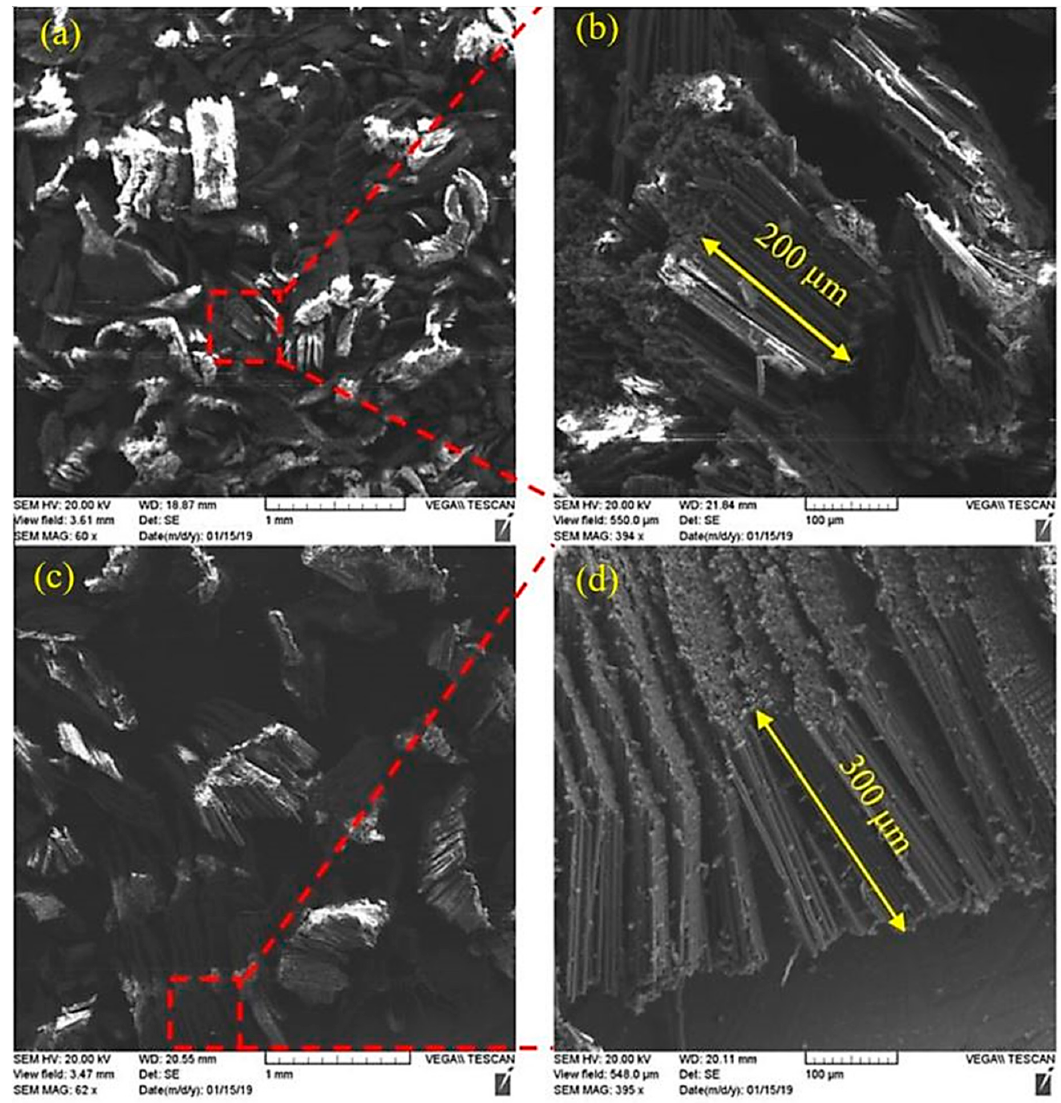
Figure 10. Effect of LF-VAD amplitude on the fiber length: ( a , b ) A m = 0.07 mm; ( c , d ) A m = 0.48 mm.